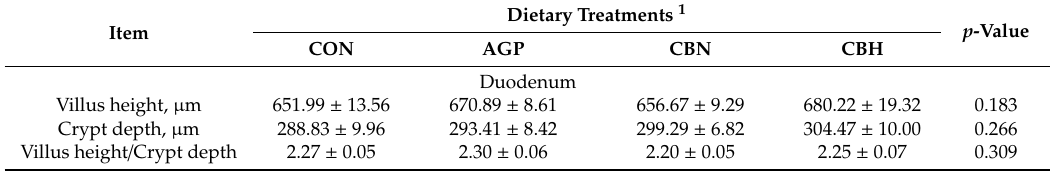
Table 6. E ff ect of dietary C. butyricum on the intestinal morphology of piglets (mean ± SE 2